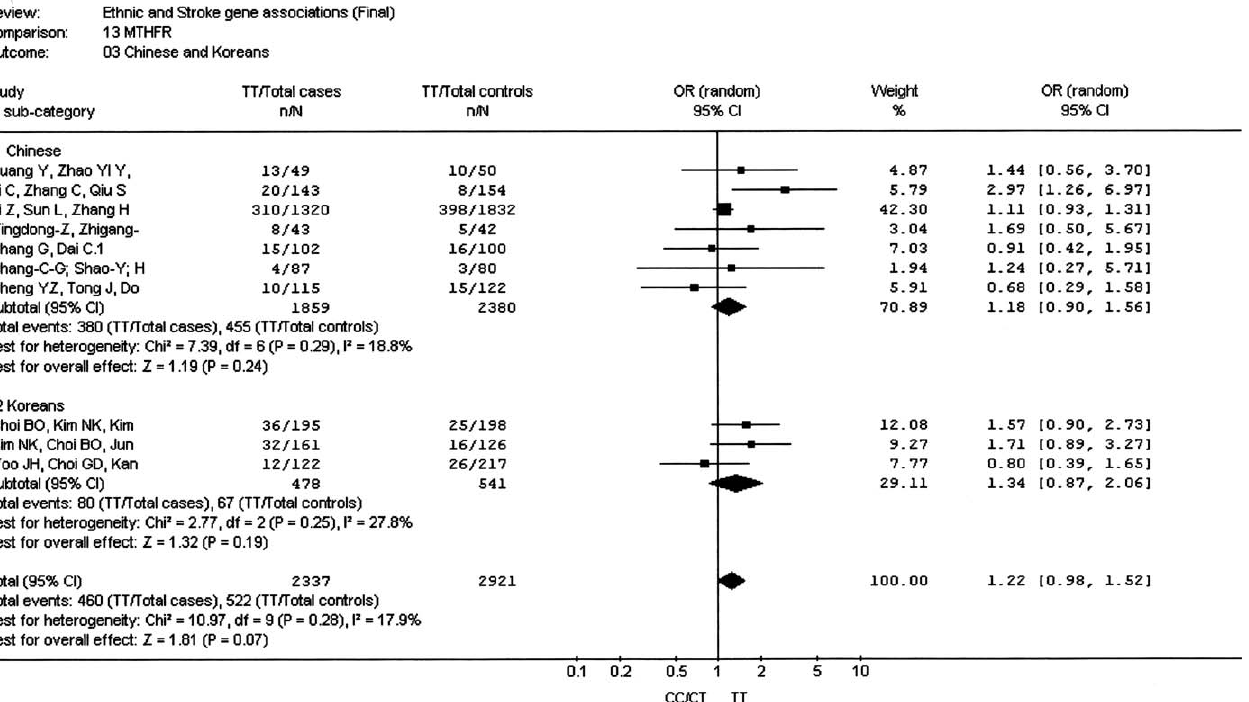
Figure 2. Meta-Analysis of Studies of the MTHFR C677T Variant and Stroke Risk in Chinese and Koreans